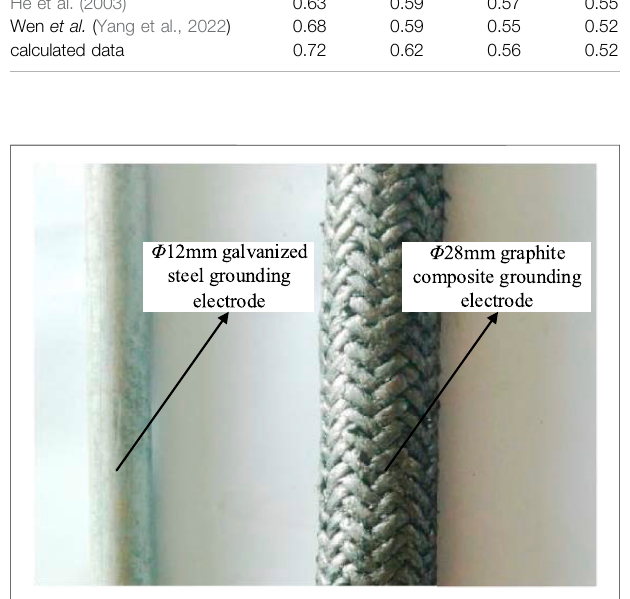
FIGURE 8 | Waveform of grounding potential rise when capacitance effect is